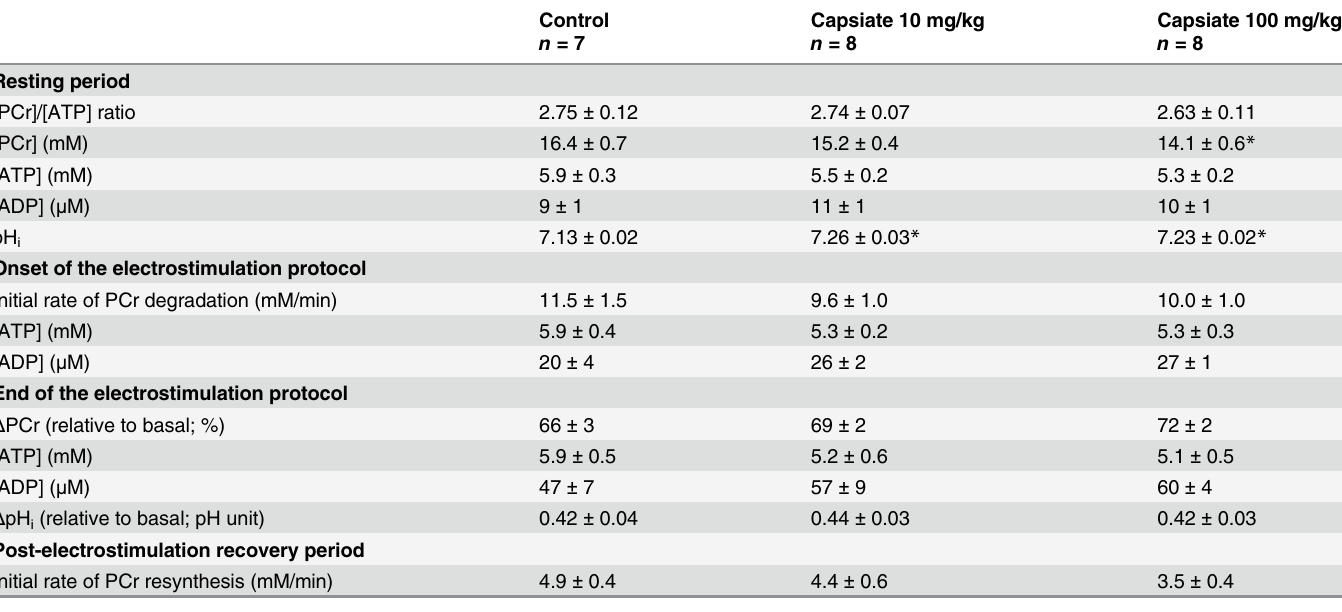
Table 2. Effect of 2-week daily administration of vehicle or capsiate on mouse gastrocnemius bioenergetics assessed in vivo using 31 P-MR